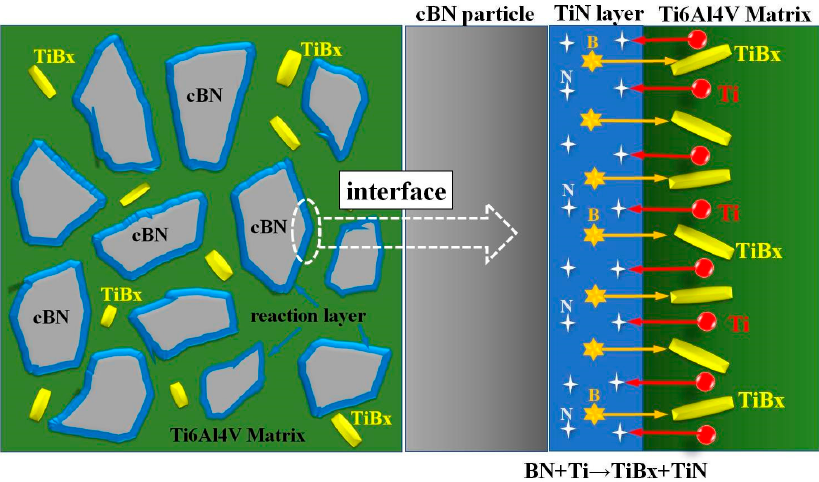
Figure 12. Reaction mechanism of the transition layer at the interface between the cBN particles and Ti6Al4V alloy